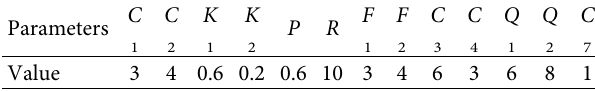
Table 4: Te parameter setting of the game subject.